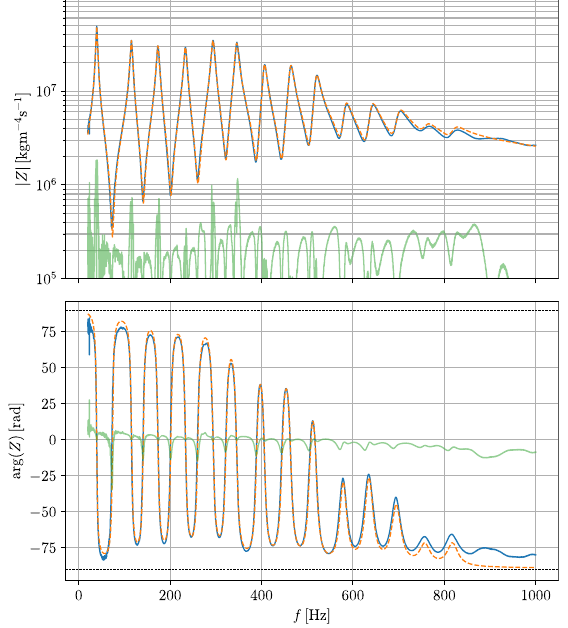
Figure 2. Modulus (top) and phase (bottom) of the input impedance of a bass trombone (A. Courtois Legend AC502) with respect to frequency. Blue curve: measured impedance; dashed orange curve: modal fi t function with N = 15 modes; green curve: error between measured and fi tted impedances, de fi ned by || Z fi t | (cid:2) | Z exp || and arg( Z fi t ) (cid:2) arg( Z exp ) respectively as regards the module and phase.